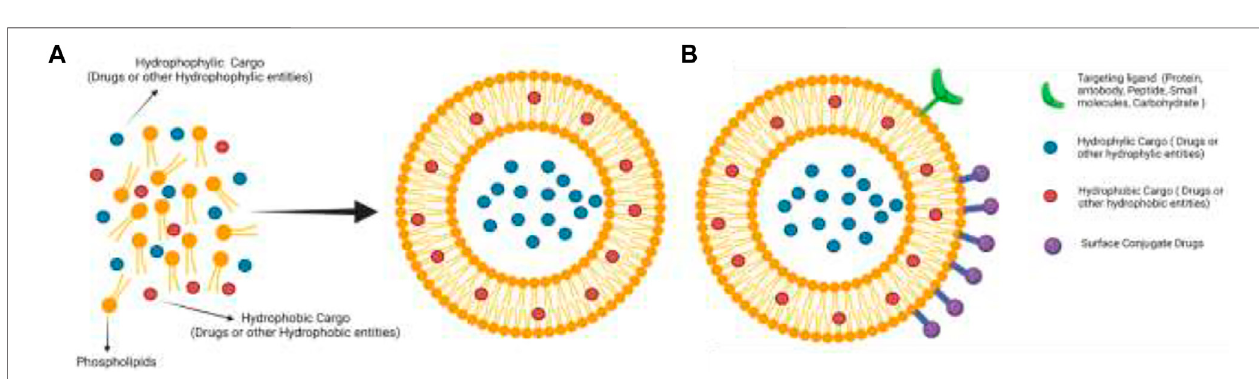
Frontiers in Chemistry |